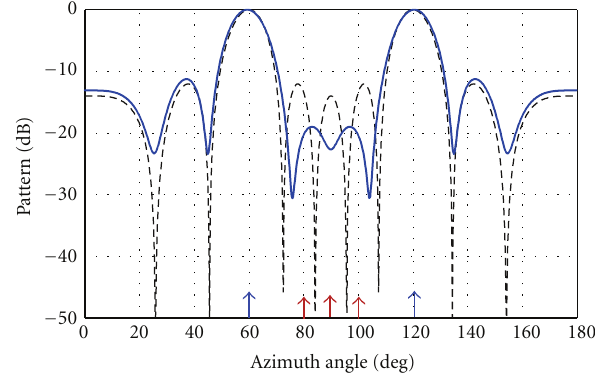
Figure 11: Adapted pattern of the array using improved LMS algo- rithm. Two desired signals (60 ◦ , 120 ◦ , power ratio of 1 each) and 3 continuously wideband probing sources (80 ◦ , p.r.: 800; 90 ◦ , p.r.: 600; 100 ◦ , p.r.: 800) with 2% bandwidth and 3 spectral lines are